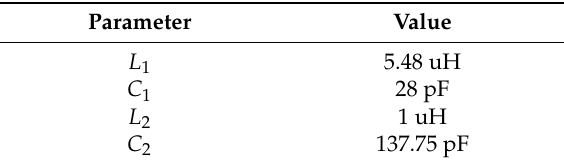
Table 2. Parameters of the RIC